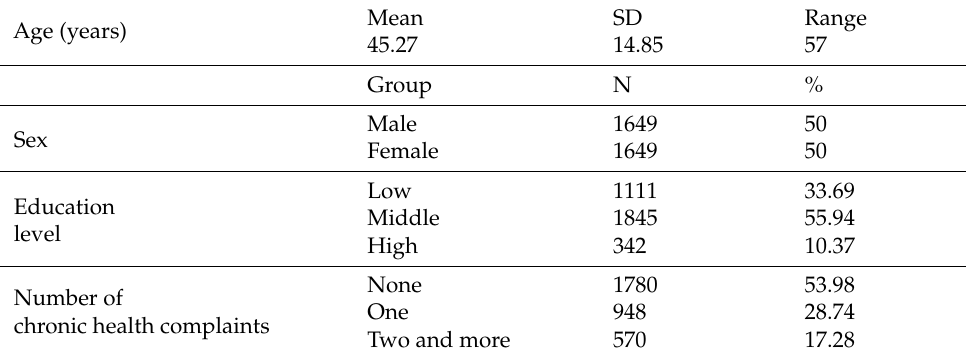
Table 1. Characteristics of the general population sample (N = 3298).